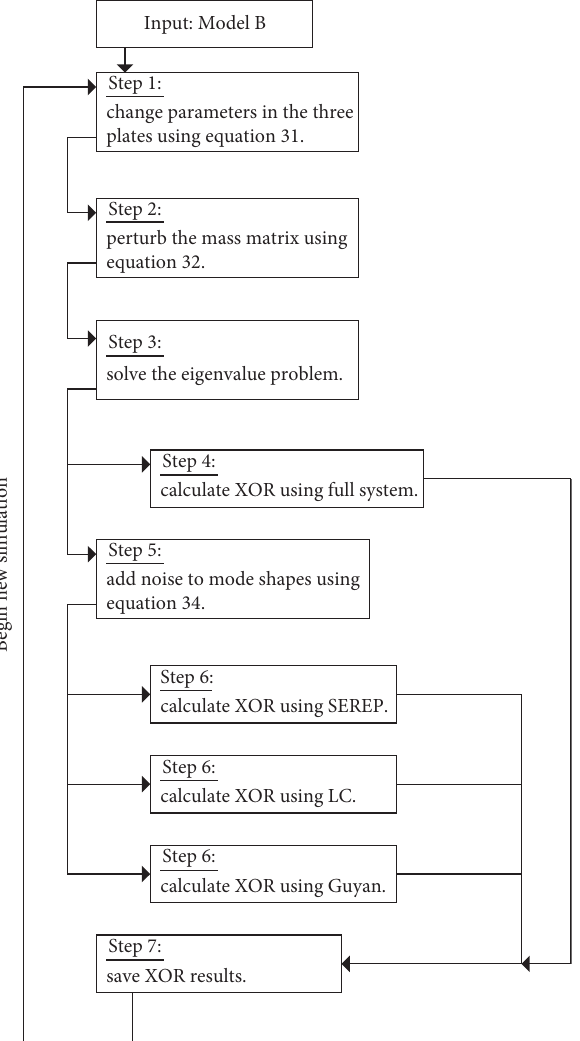
Figure 12: Illustration of the framework of the numerical